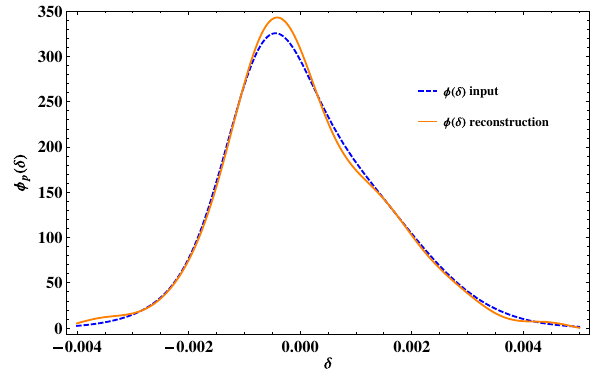
FIG. 8. Reconstruction of a nonsymmetrical momentum dis- tribution.